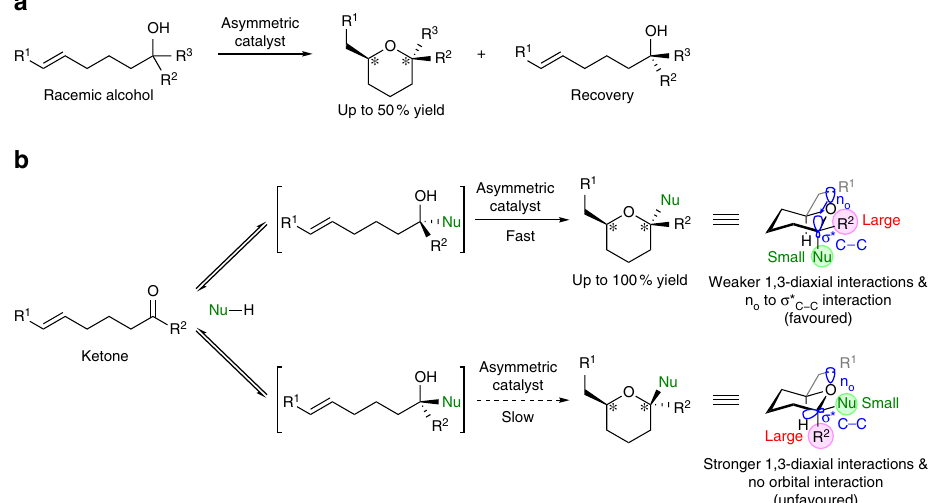
Fig. 1 Simultaneous construction of two stereogenic centres in tetrahydropyrans. a Cycloetheri fi cation via kinetic resolution of racemic alcohols. b Cycloetheri fi cation via dynamic kinetic resolution involving reversible addition of a carbon nucleophile to